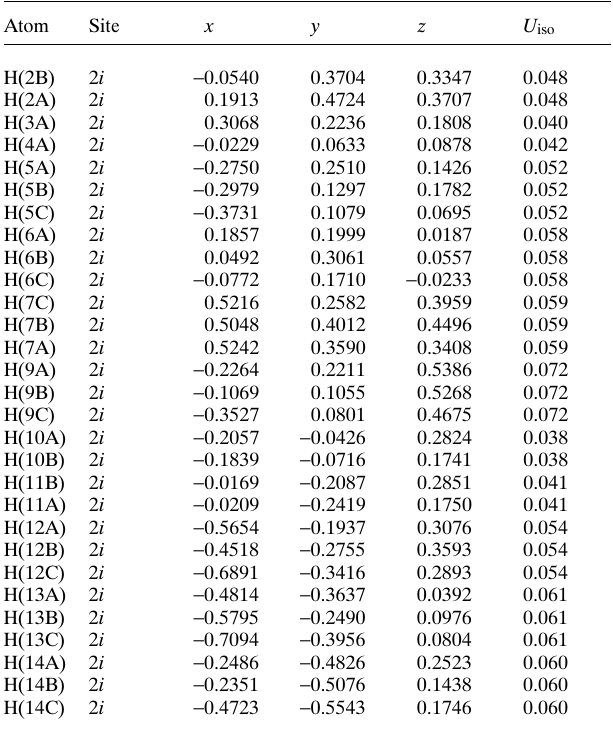
Table 2. Atomic coordinates and displacement parameters (in Å 2 )